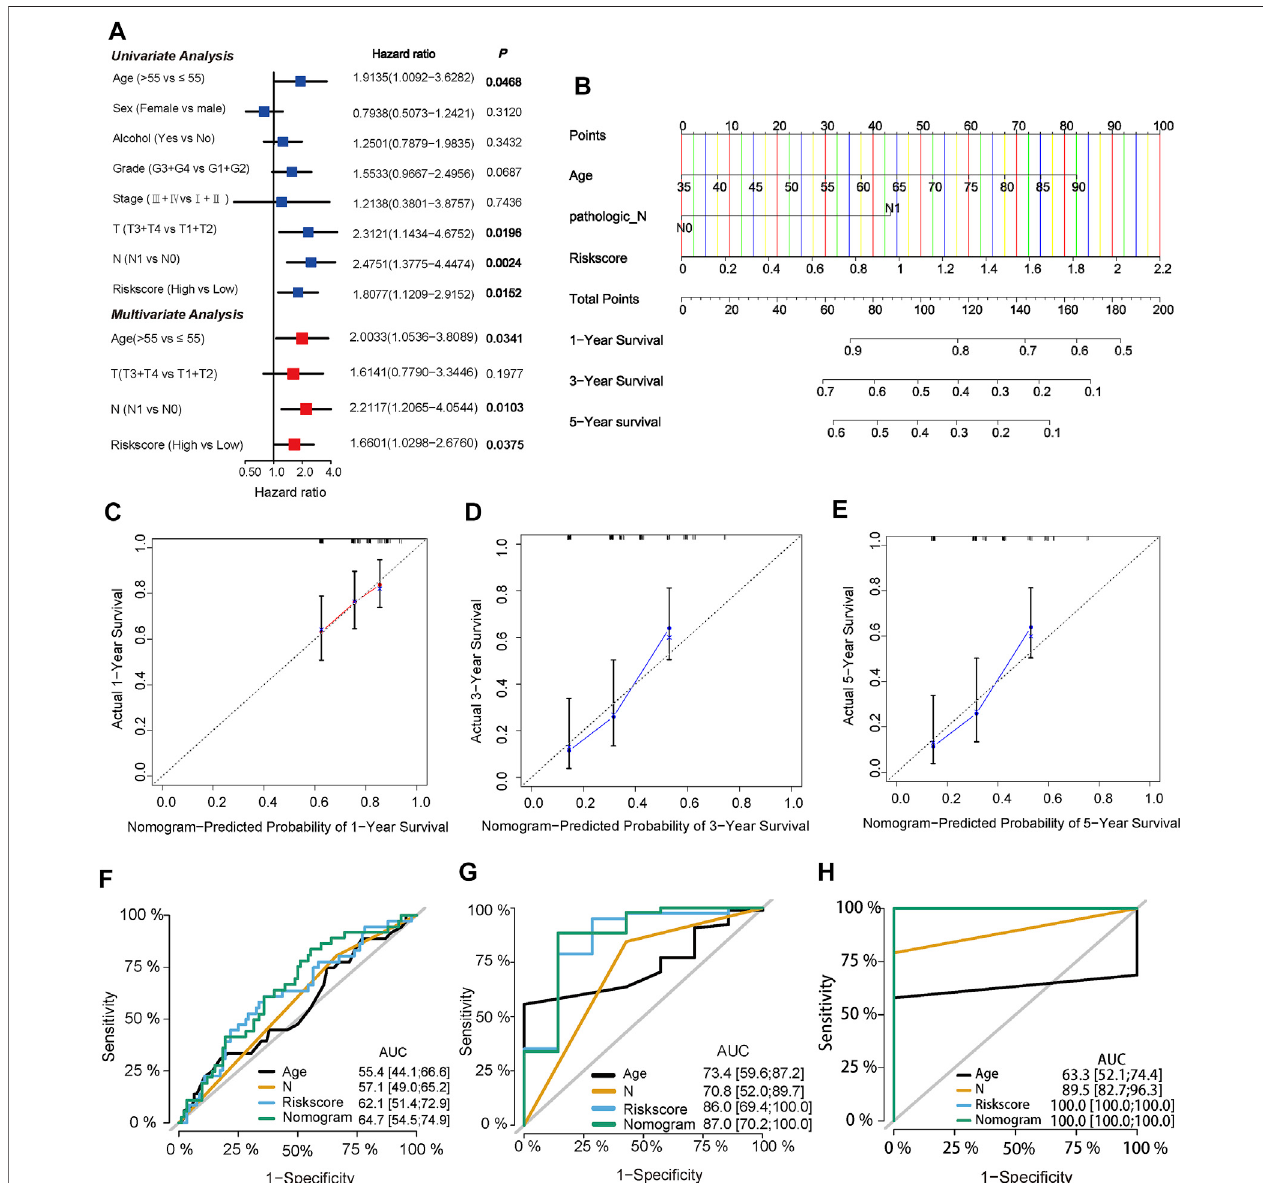
FIGURE6| Identi fi cationofindependentprognosticfactorsandconstructionofapredictivenomogram (A) UnivariateCoxregressionanalysisandmultivariateCox regressionanalysisofriskscoreandclinicalcharacteristicsinTCGAcohort (B) NomogramoftheTCGAcohortpredictingthesurvivalrateat1,3,5-yearsforPCpatients (C,D,E) Calibration plots for the nomogram (F,G,H) ROC curve analysis of the three independent prognostic factors and nomogram.